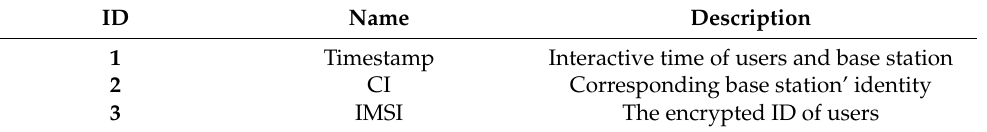
Table A1. Recorded data